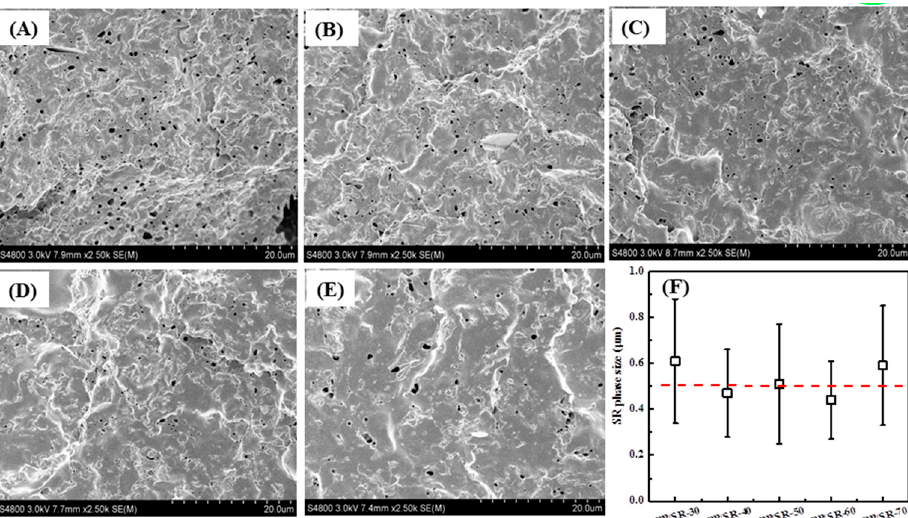
Figure 2. SEM images of etched surfaces for different polypropylene (PP)/silicone rubber (SR) thermoplastic vulcanizates (TPVs). ( A ) PP/SR-30, ( B ) PP/SR-40, ( C ) PP/SR-50, ( D ) PP/SR-60, ( E ) PP/SR-70 and ( F ) SR phase size statistical result.